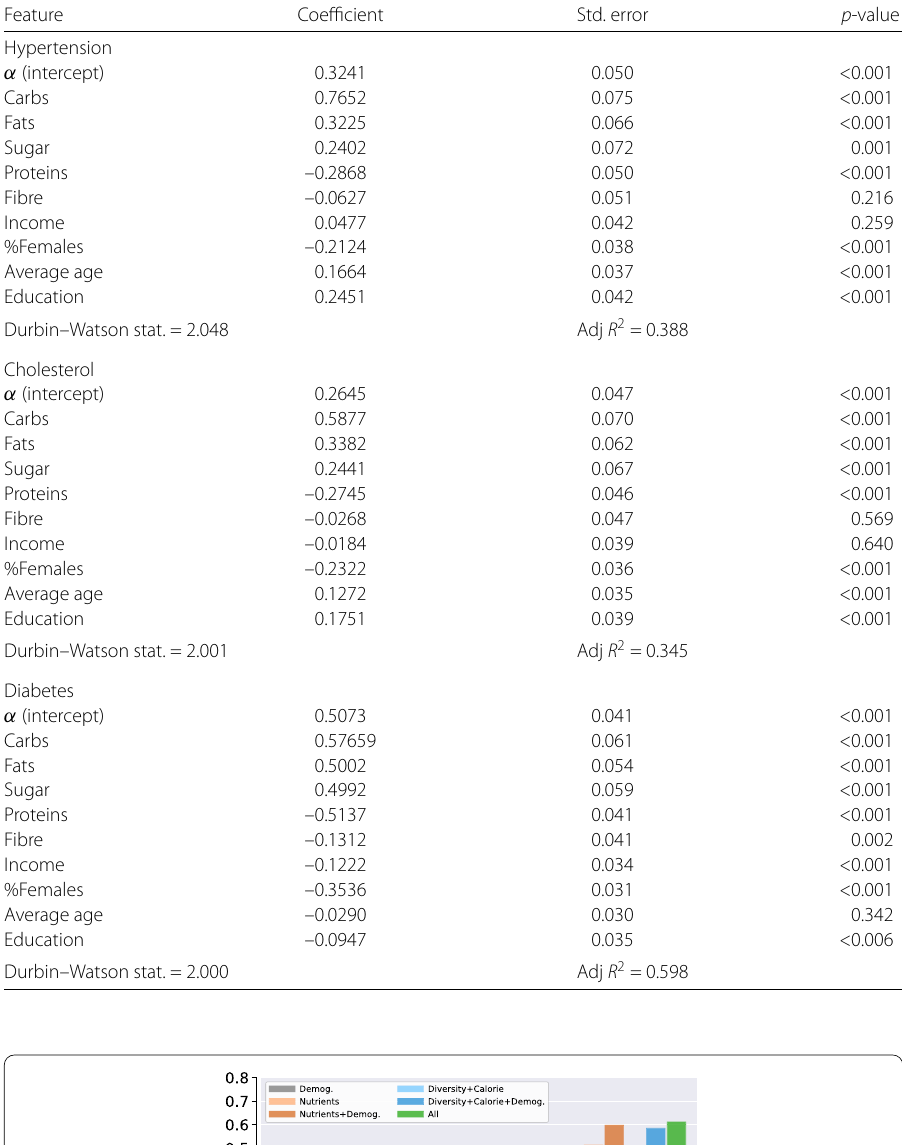
Table 1 Linear regressions that predict the three chronic diseases from individual nutrients and socio-demographic control variables (income, gender, age, education level) Feature